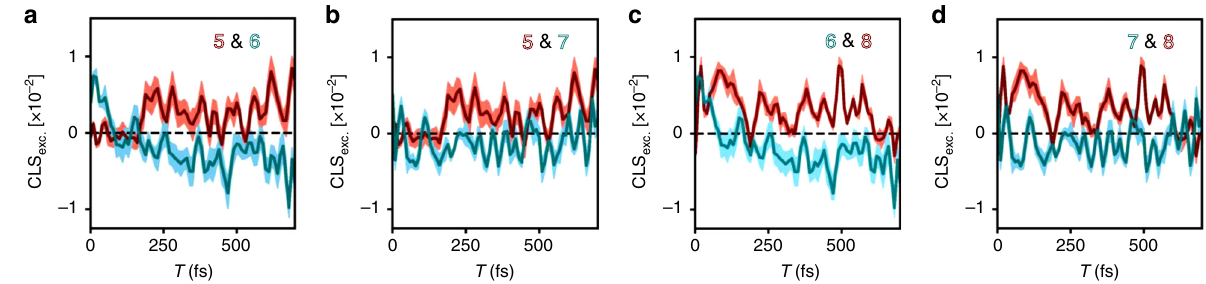
Fig. 4 Center line slope dynamics of LHCII trimer. Time domain center line slope (CLS) dynamics along the excitation axis of features fi ve through eight. Pairings have been made to emphasize the striking complementary behavior. The pairs of features shown are a fi ve and six, b fi ve and seven, c six and eight, and d seven and eight. The CLSs are colored according to the peak labels in the top right corner of each plot. Shaded light red or blue regions around each CLS indicate the standard error from the linear fi ts used to calculate the CLS